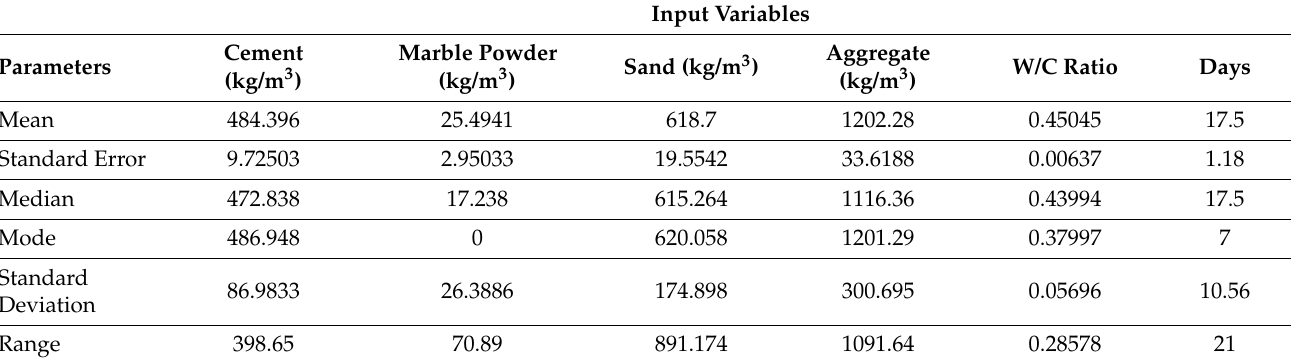
Table 4. Input parameters description analysis.